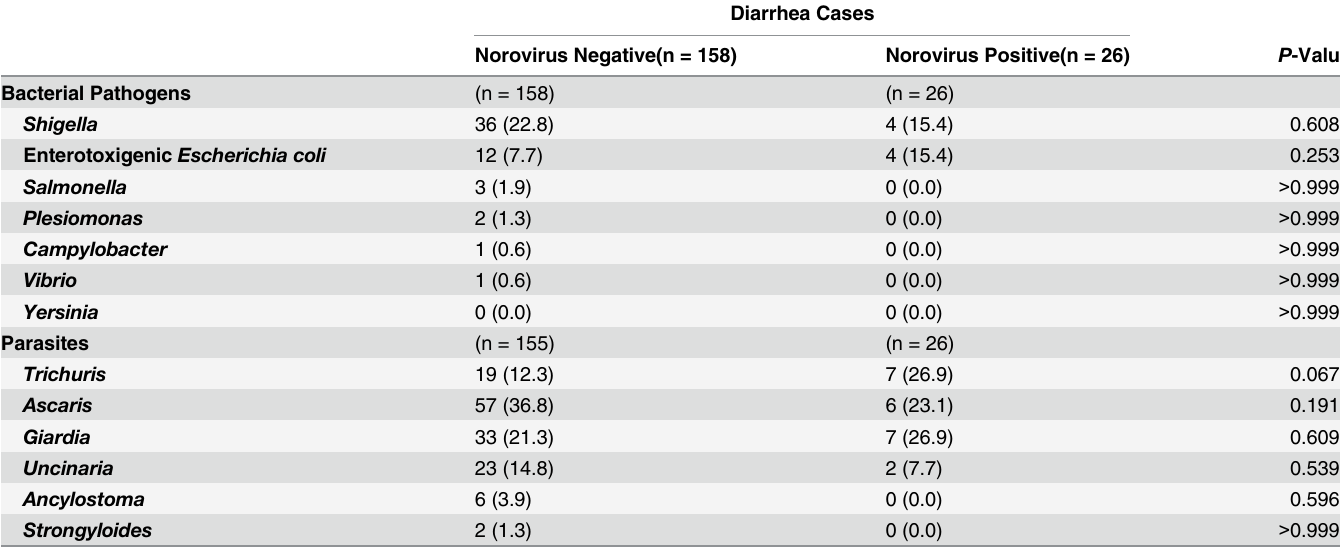
Table 4. Laboratory stool results for norovirus positive versus negative diarrhea cases, no. (%).